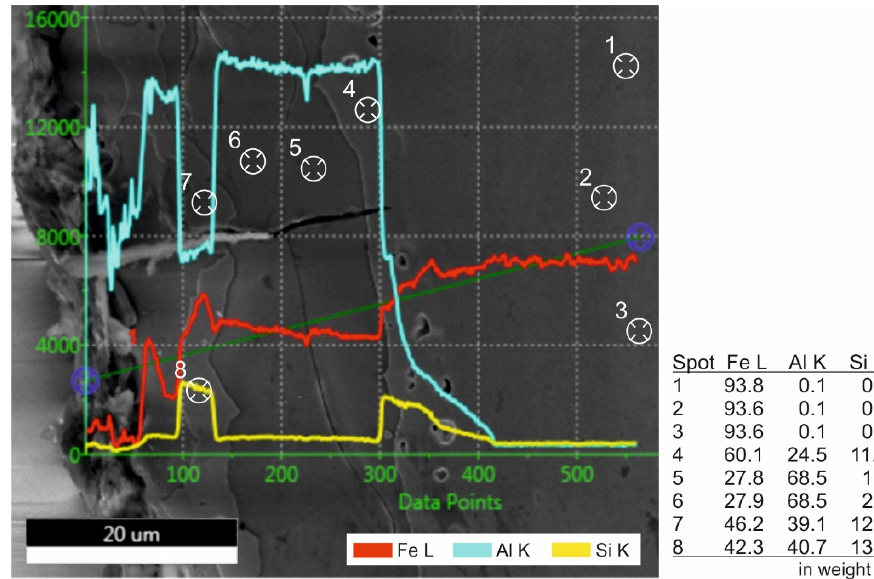
Figure 4. The EDS analysis of surface coating and BM.